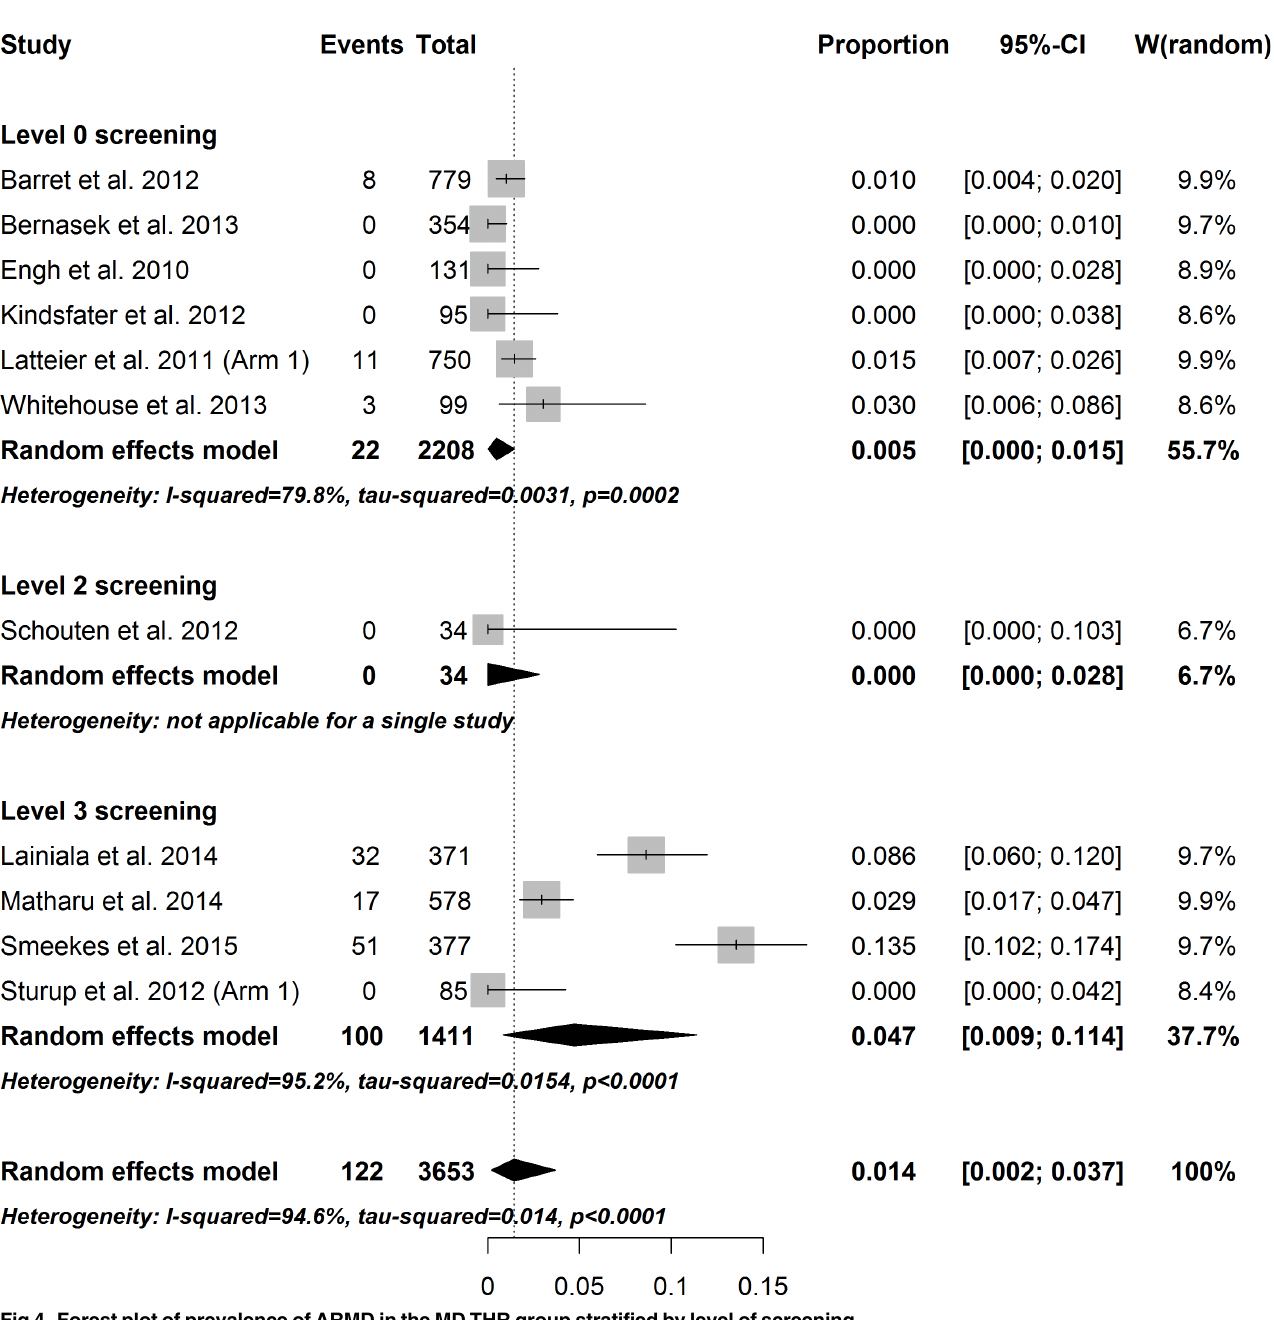
Fig 4. Forest plot of prevalence of ARMD in the MD THR group stratified by level of screening.